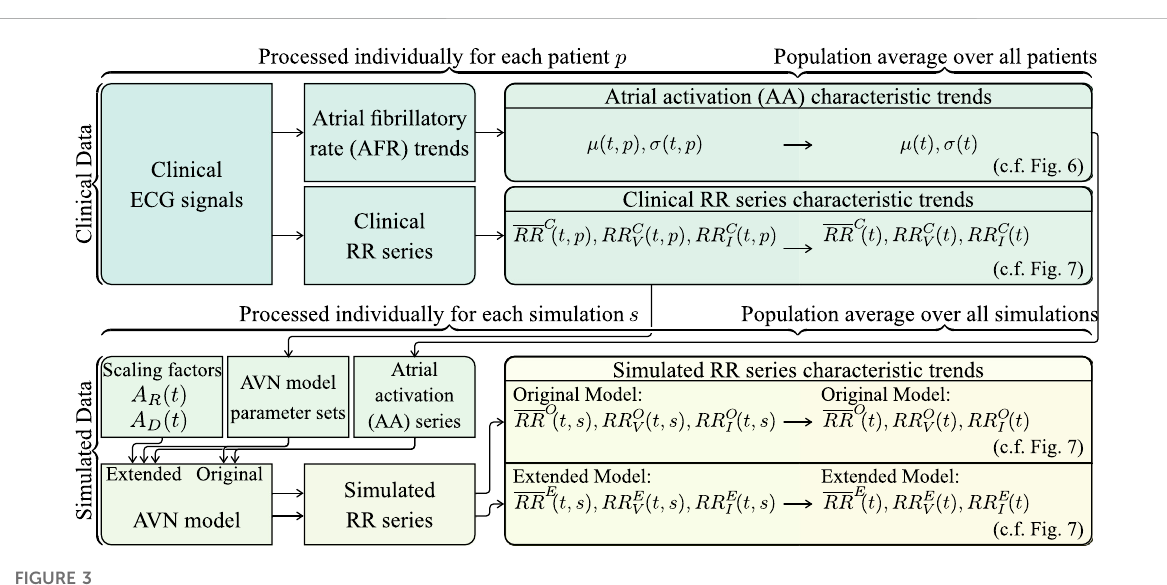
The factors A R and A D model the combined effect of changes in sympathetic and parasympathetic activity and do not differ between the SP, FP and CN.